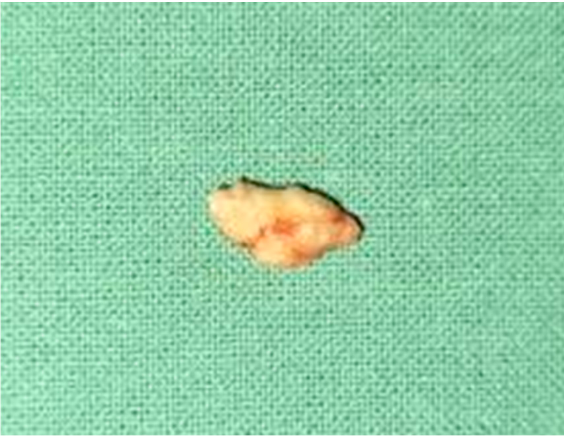
Figure 4. Extracted Wharton duct calculus .